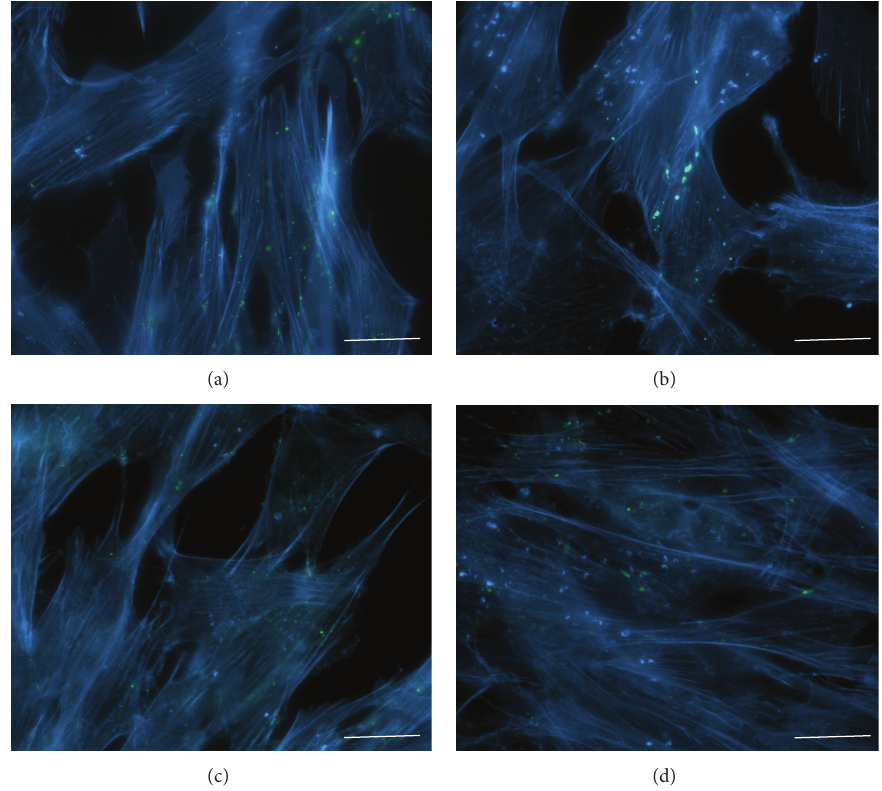
Figure 9: Impact of hyperthermia on actin filament organization in SkMs under control conditions (a); after hyperthermia (6h at 42 ∘ C) (b); under control conditions with XG-102 (4 𝜇 M) (c); after hyperthermia (6h at 42 ∘ C) with XG-102 (4 𝜇 M) (d). Blue: F-actin labeled with Alexa Fluor 594 phalloidin; green: Cx43-EGFP. Scale bar 25 𝜇